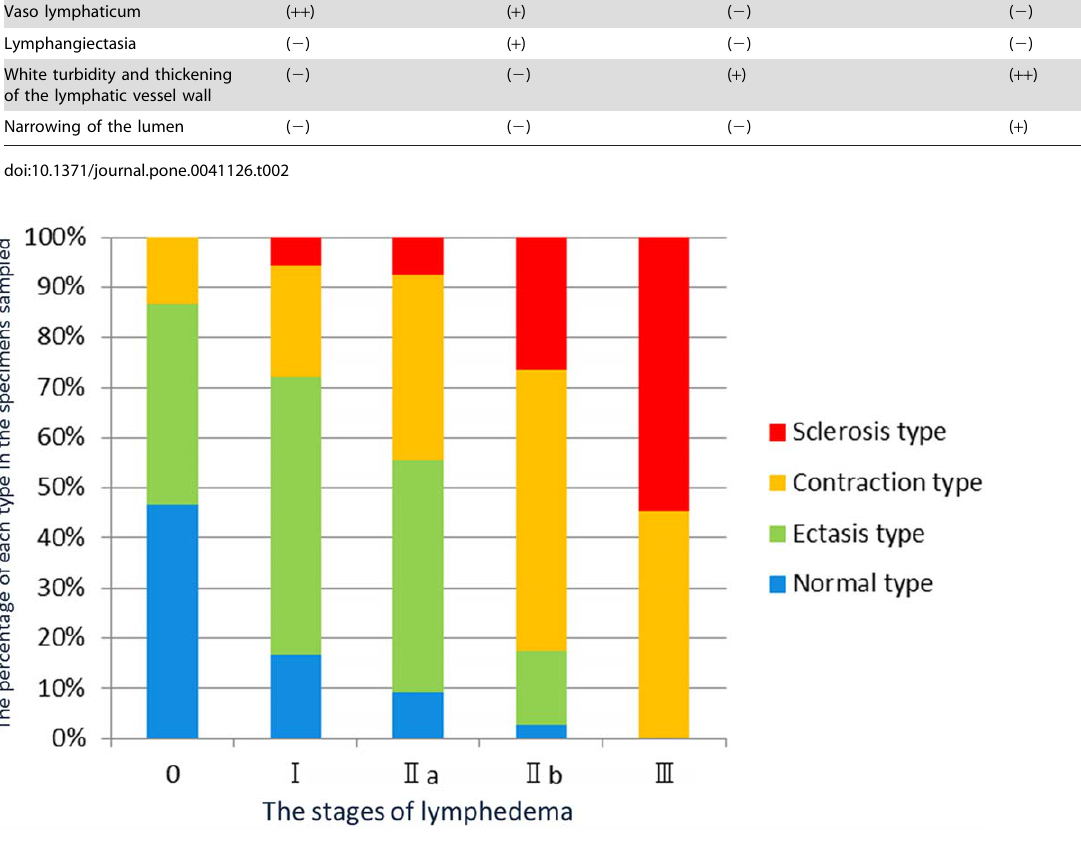
Figure 1. Association between the classification of the types of collecting lymphatic vessels and the staging of lymphedema. The horizontal axis shows the stages of lymphedema. The vertical axis shows the percentage of each type in the specimens sampled at each stage of the disease. doi:10.1371/journal.pone.0041126.g001 PLoS ONE |